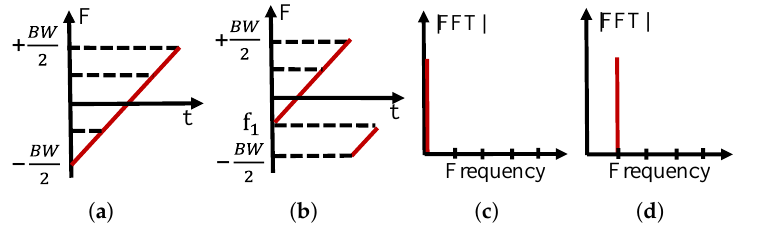
Figure 2. Illustration of LoRa modulation. ( a ) Base up-chirp. ( b ) An example of a modulated chirp symbol whose frequency start at f 1 . ( c ) The demodulation result of ( a ). ( d ) The demodulation result of ( b ).